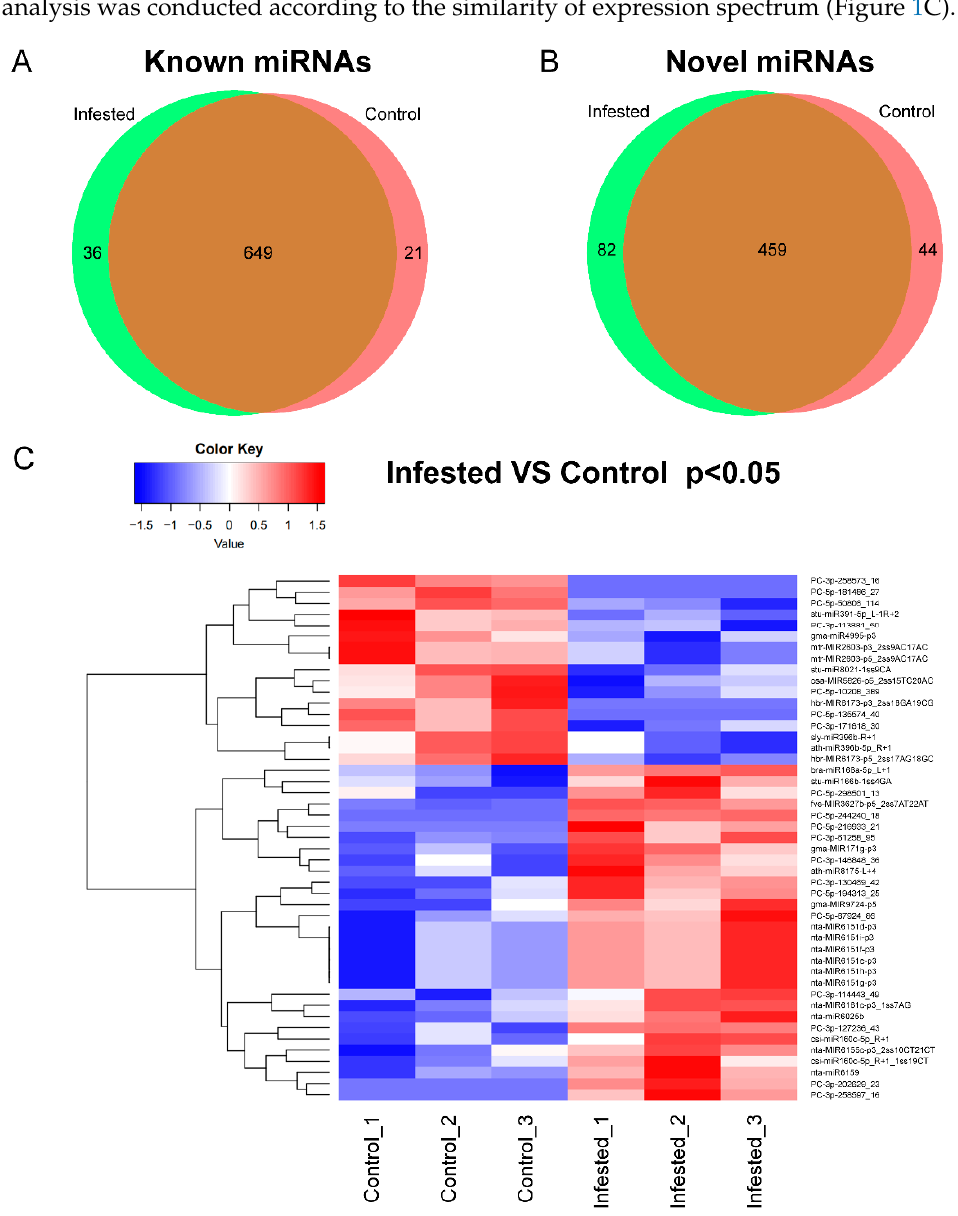
Figure 1. The identification of miRNAs. ( A , B ) Distribution of miRNAs between Control and Infested groups. ( C ) Cluster analysis of miRNAs. The color ranges from blue to red indicated the amount of expression (log 10 (norm value)) from low to